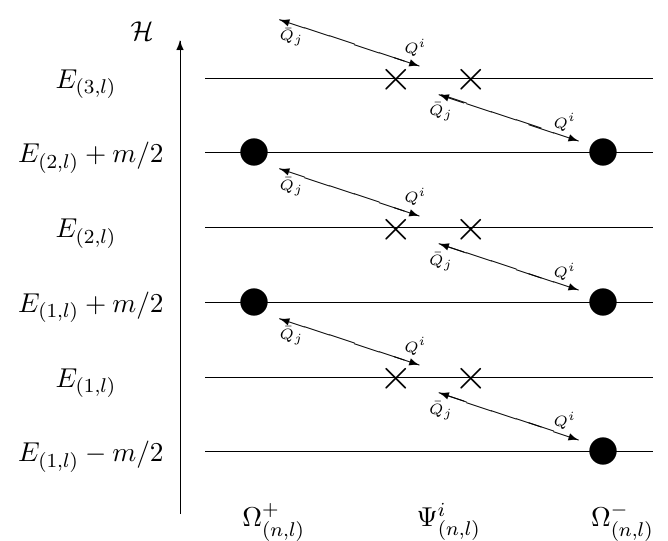
Figure 1 . Degeneracy of energy levels with a fixed number l . Bosonic (circles) and fermionic (crosses) states of the 4-fold SU (2 | 1) multiplet, characterized by the number n , fill the energy levels E ± m/ 2 and E ( n,l ) ( n,l )